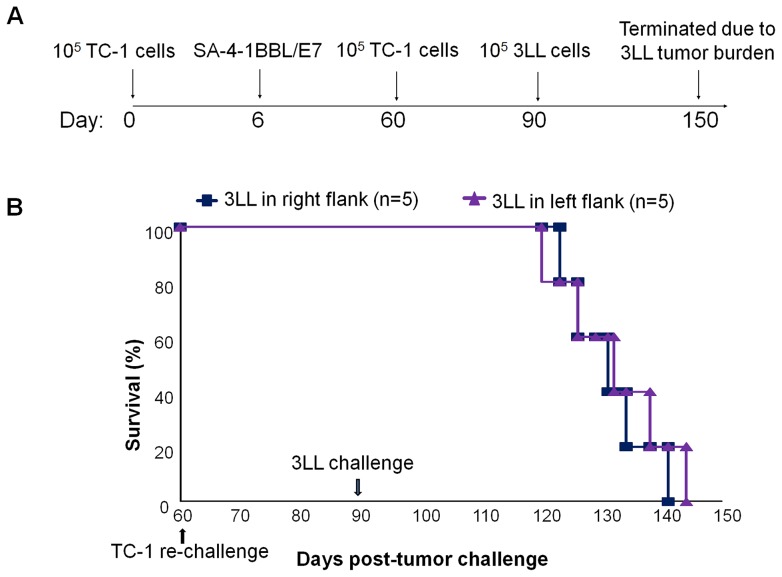
Long-term immune memory induced by SA-4-1BBL/E7 vaccine is systemic and tumor-specific.C57BL/6 mice that had eradicated TC-1 tumors in response to vaccination with SA-4-1BBL/E7 were given a second dose of TC-1 tumor cells (1×105) in either left or right flank 60 days after primary tumor challenge to evaluate long-term immune memory and if the memory is systemic. (A) Schematic depiction of the experimental procedure. (B) Survival. None of the mice developed TC-1 tumors in left or right flanks within the 30-day observation period at which time the animals were inoculated with live 1×105 heterologous 3LL tumor cells into the opposite flanks to the last TC-1 challenge. All long-term mice developed 3LL tumors in a similar tempo to naïve (data not shown) mice without recurrence of TC-1 tumor growth, demonstrating that anti-tumor immune responses are systemic and tumor type-specific.